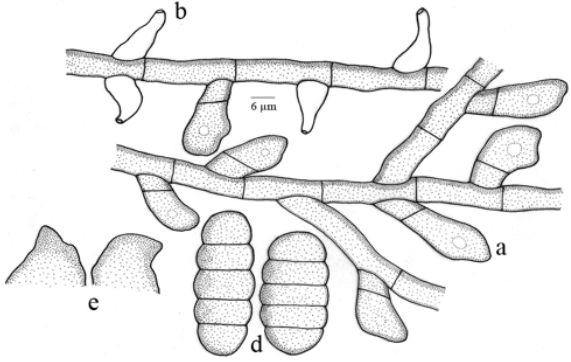
Figure 19. Asteridiella micheliae a - Appressorium; b - Phialide; d - Ascospores; e - Perithecial wall